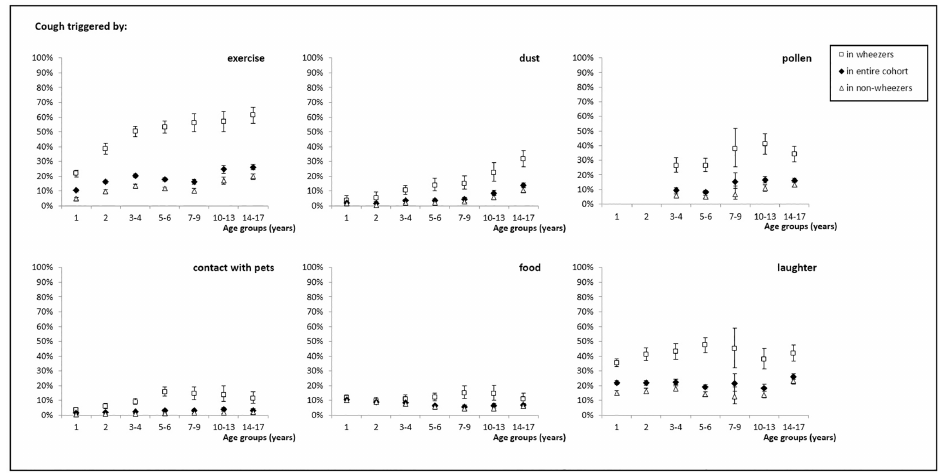
Fig 2. Prevalence of cough triggered by exercise,house dust, pollen, pets, food and laughter or crying in the entire cohort, and among children with wheeze and non-wheezers, for different age groups. Prevalence(%) with 95%